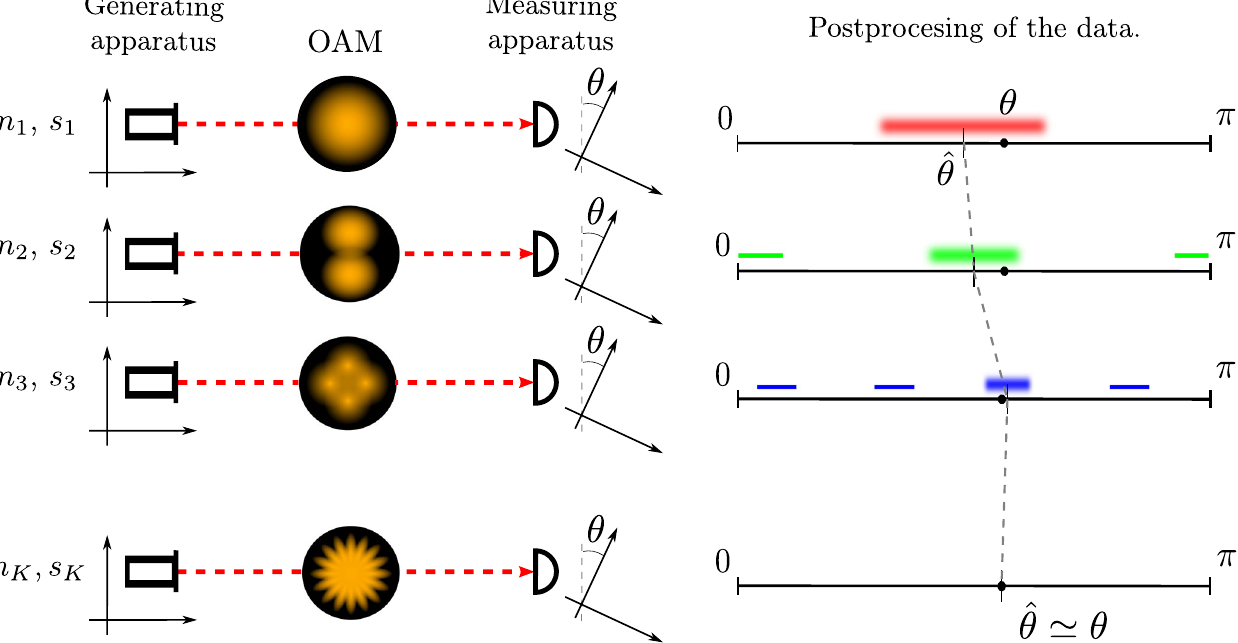
ð θ Þj i characterized by a resource number s Fig. 1 Conceptual scheme of the estimation protocol. At stage i , n i copies of the state Ψ s i are i employed. In our experiment, the encoded parameter is the rotation angle θ between two reference systems, associated, respectively, with two platforms corresponding to the photon generation stage and to the measurement apparatus. The quantum resource is related to the total angular momentum of the photons. Each stage is successful if and only if it could identify the correct interval for the angle θ among the possible ones, using the information on the previously selected interval. This allows the last stage (with maximal sensitivity) to produce an ^ θ unambiguous estimator . In the fi gure, the plausible intervals for the phase, computed from the outcomes of the independent and non- adaptive measurements are colored, and the selected one is